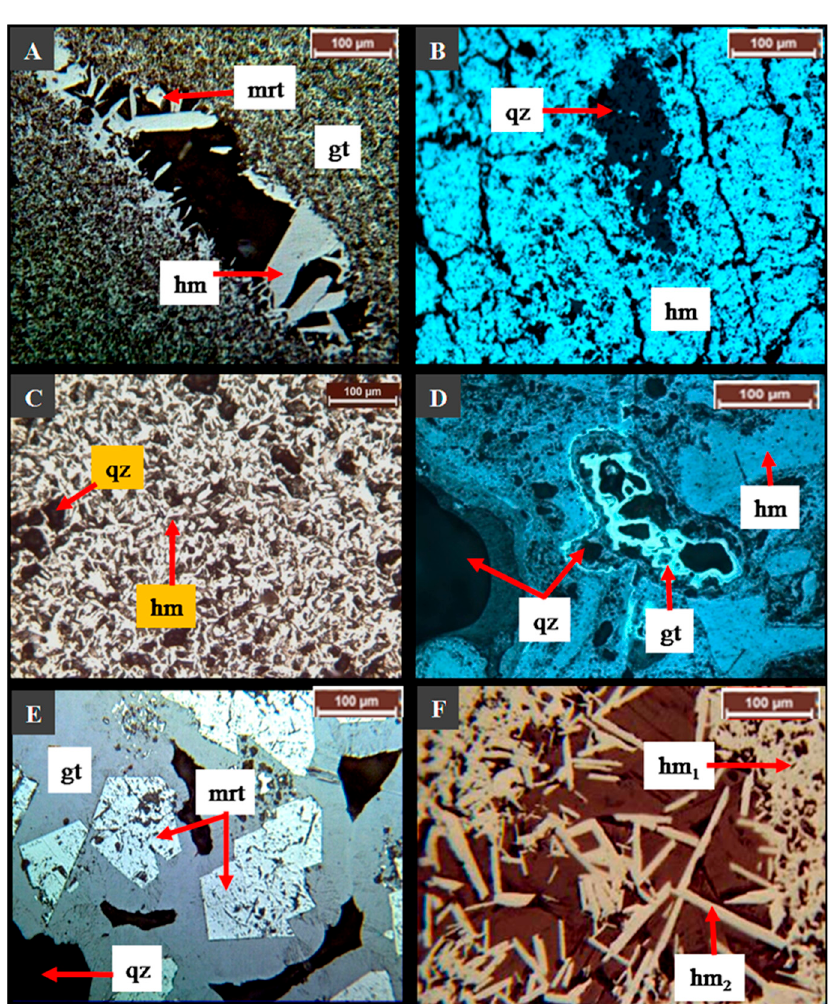
Figure 10. Photomicrographs showing: ( A ) hard massive ore consisting mainly of hematite (hm), martite (mrt) and goethite (gt) along with relict magnetite; ( B ) hard laminated ore consisting of micro-platy hematite (hm) along with quartz (qz) in voids; ( C ) blue dust containing micro-platy hematite (hm) along with fine grained quartz (qz); ( D ) lateritic-goethitic ore showing colloform banding and spheroidal texture, respectively; ( E ) martitized magnetite grains (mrt) in goethitic ore; and ( F ) growth of secondary micro-platy hematite (hm 2 ) around primary hematite grains (hm 1 ).